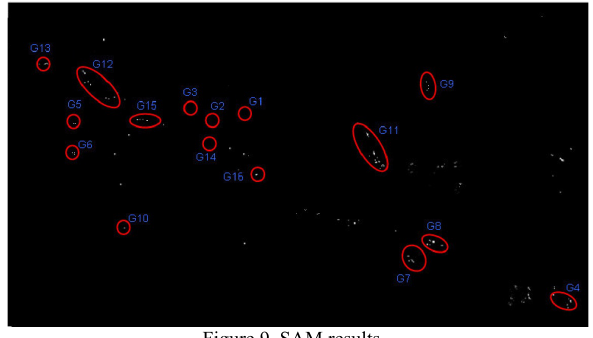
Figure 9. SAM results.